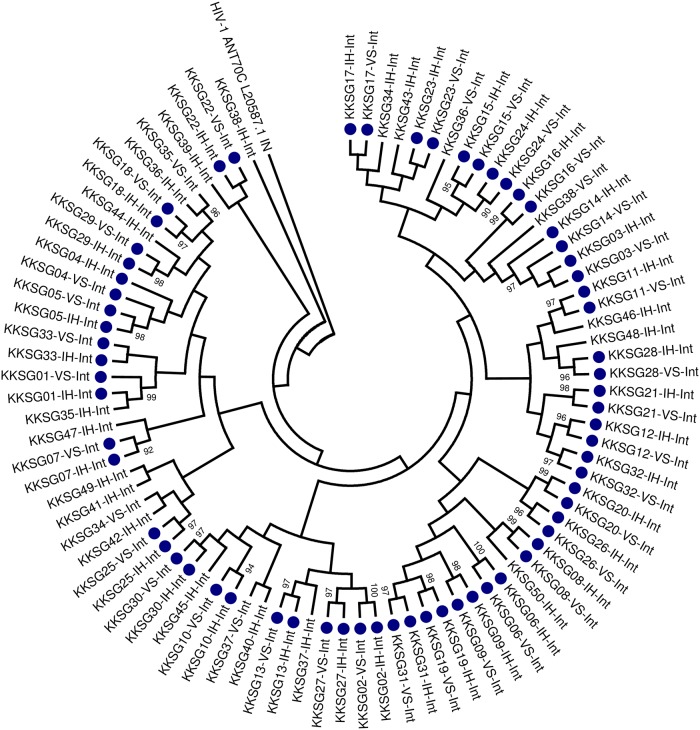
Molecular phylogenetic analysis by maximum likelihood method of 88 integrase sequences derived by the ViroSeq™ HIV-1 integrase RUO genotyping kit (VS-Int) and in-house “home-brew” integrase drug resistance assay (IH-Int).The numbers next to the nodes represent Bootstrap values (1000 replicates) >90.